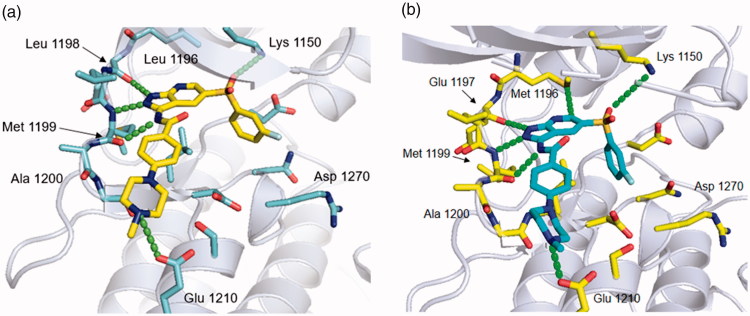
Docking study of 10g on ALK kinase domain (a) WT and (b) L1196M based on an X-ray crystal structure (PDB code: 2XP2).